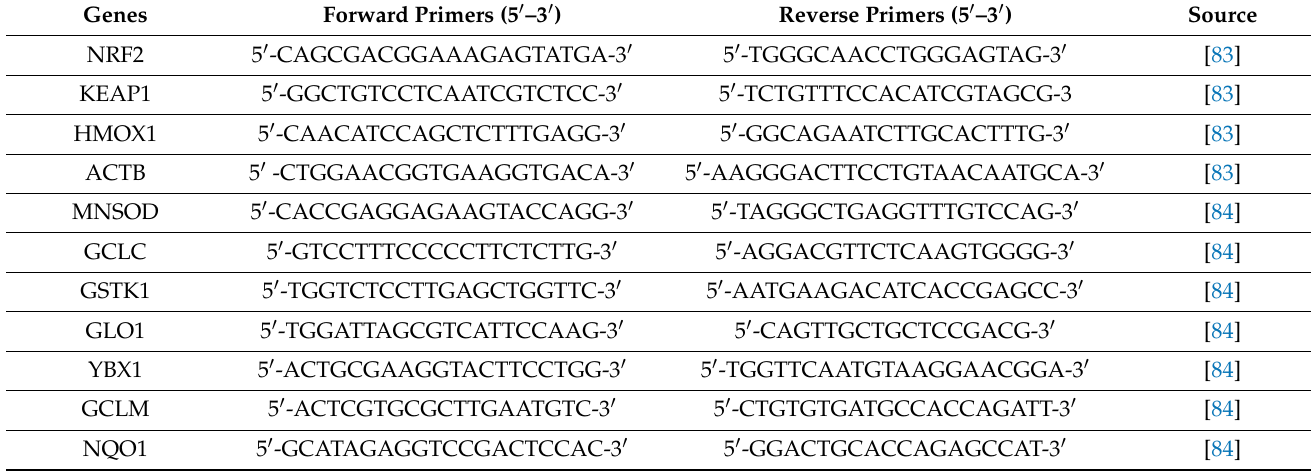
Table A2. List of the qRT-PCR